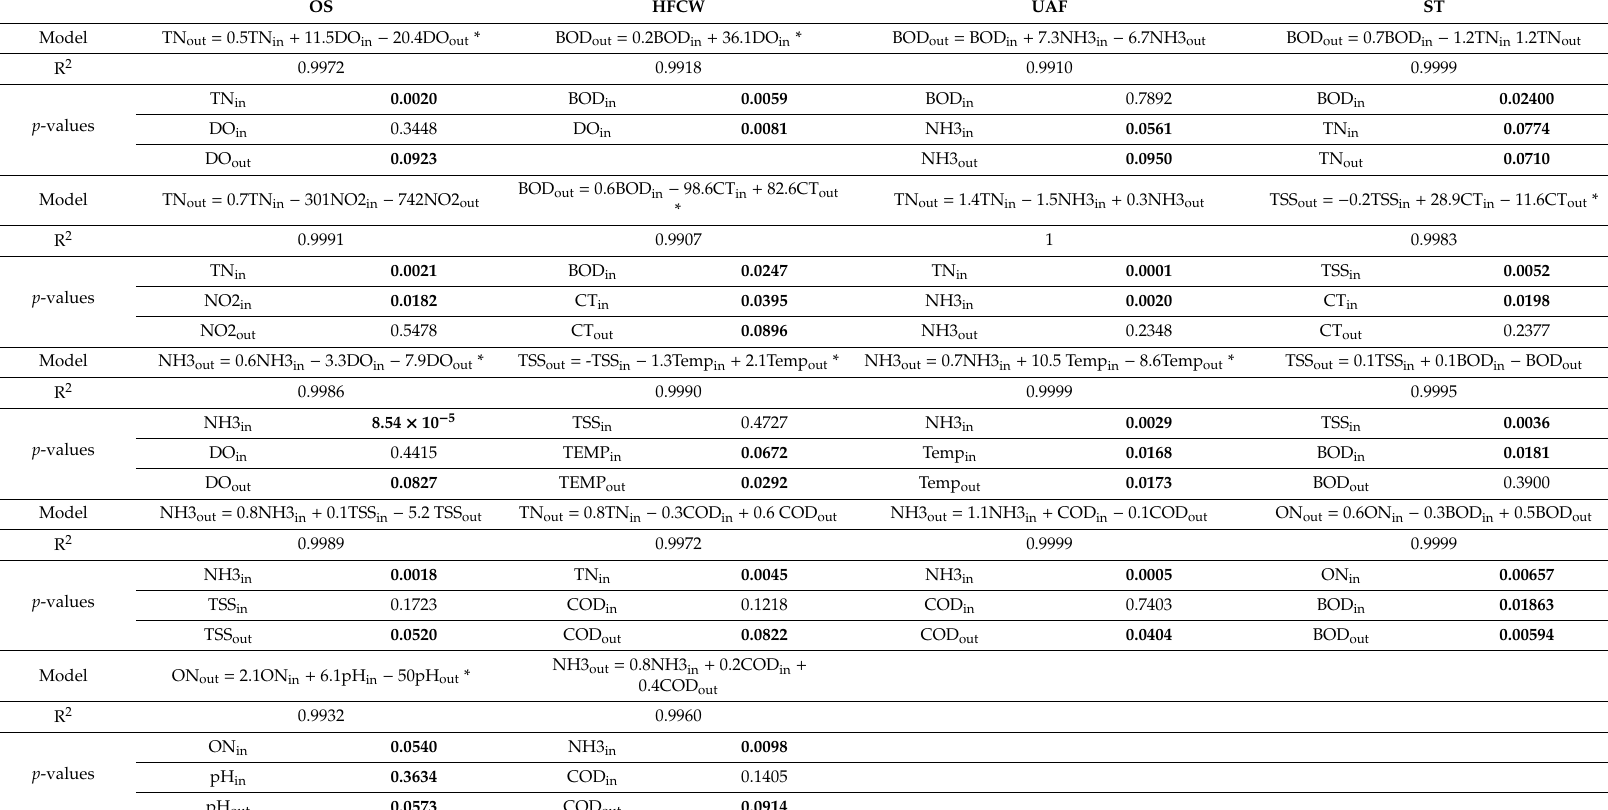
Table 5. Relevant multiple regression